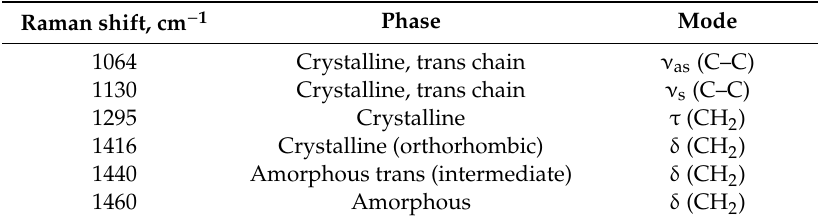
Table 1. Vibrational phase and modes of the Raman spectrum of high-density polyethylene